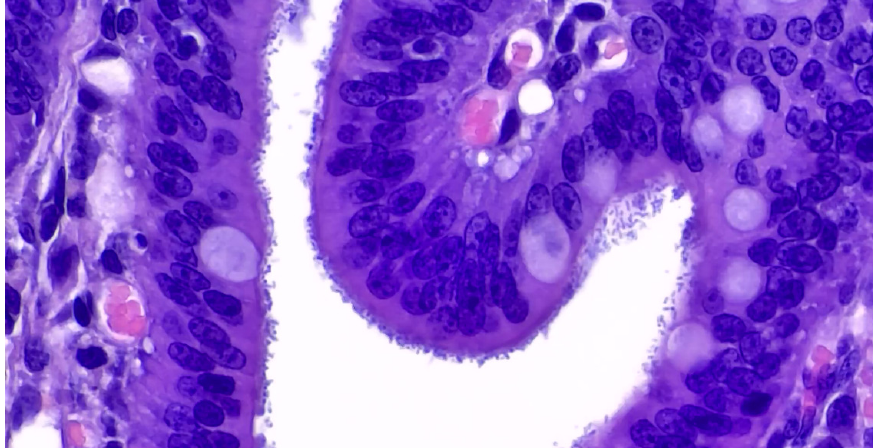
Figure 9. Pig 45 days old. Colibacillosis due to F4, STa, STb ETEC strain. Histological evaluation of jejunum shows bacterial layers attached to the brush border enterocytes (Haematoxylin and Eosin stain, 60×).